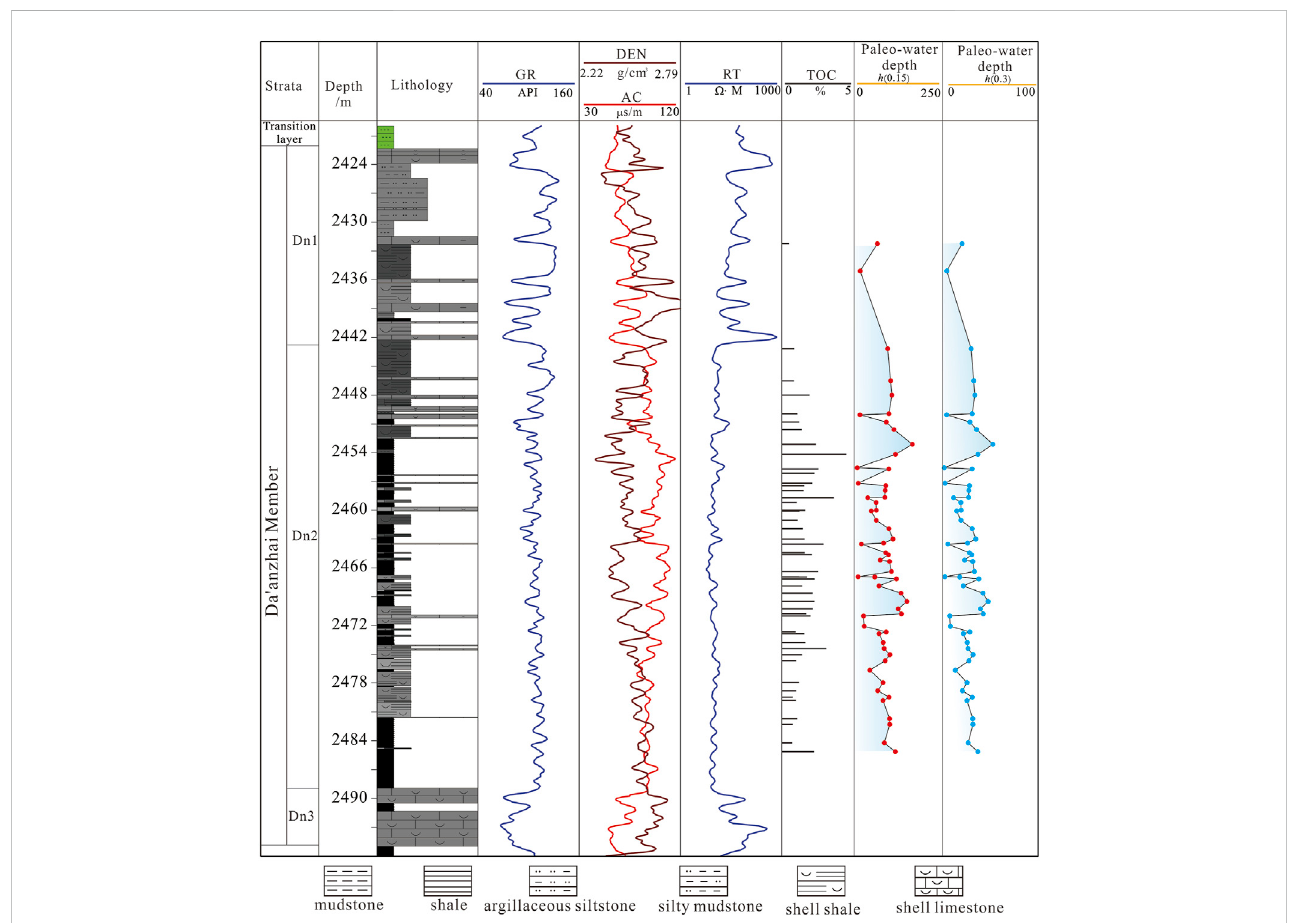
Vertical distribution of paleo-water depths in Well RA 1 in the Central Sichuan Basin; GR, gamma logging; DEN, Density Logging; AC, Acoustic logging; TOC, total organic carbon; Rt, True formation resistivity, Dn1, Dn2, Dn3: sub-members of the Da ’ anzhai